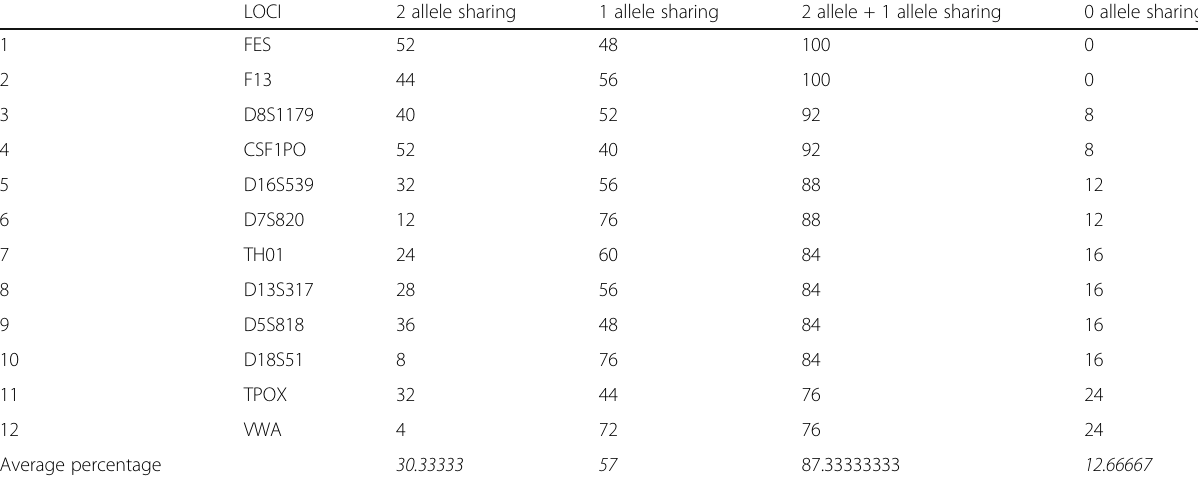
Table 2 Allele sequence sharing from highest to lowest locus